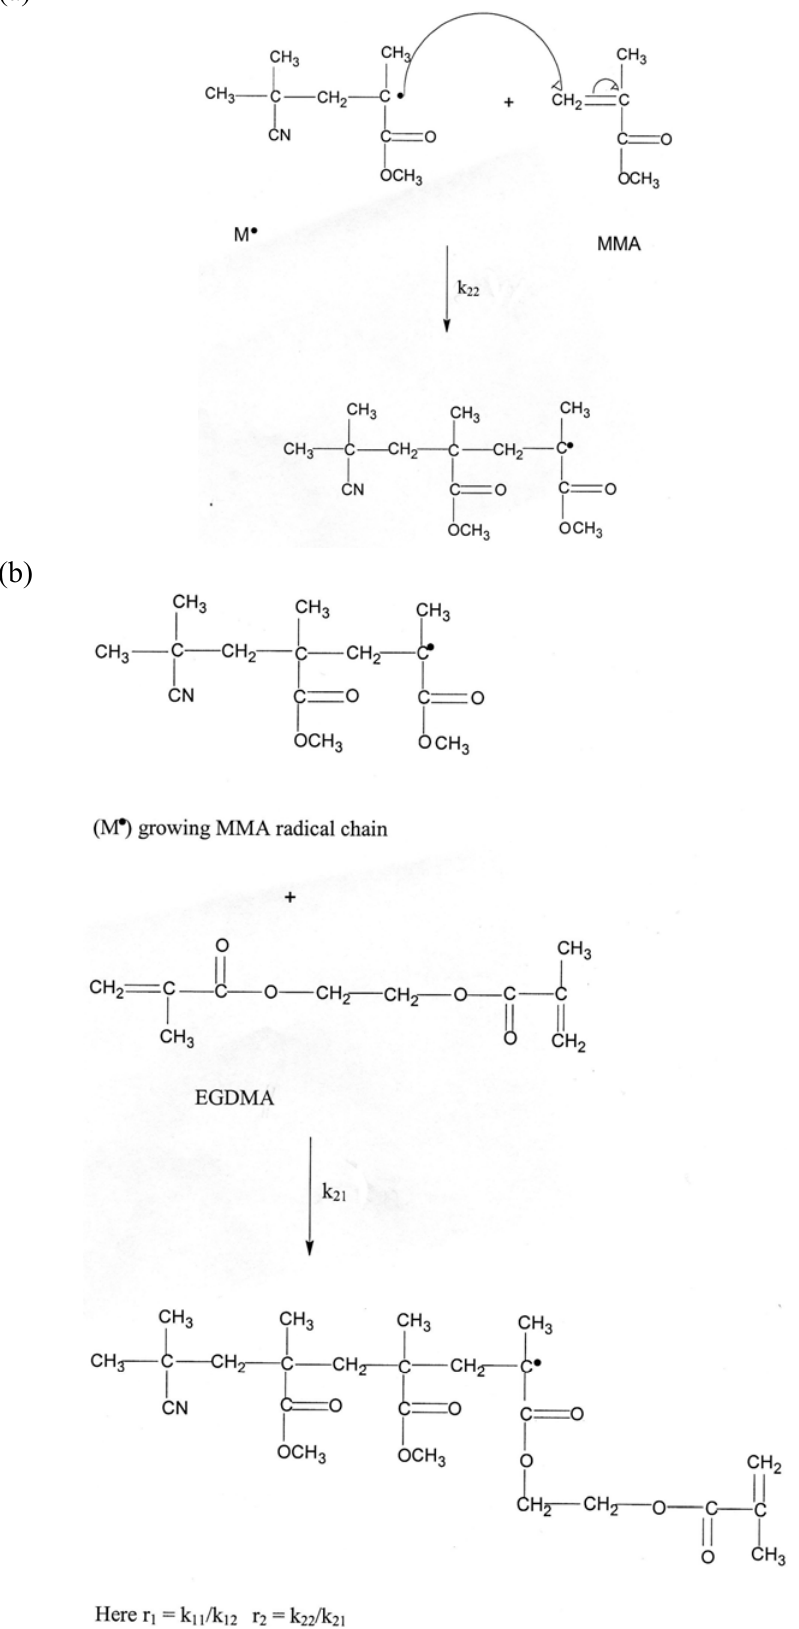
Figure 5. (a). MMA radical adds its own monomer; (b). MMA radical adds EGDMA